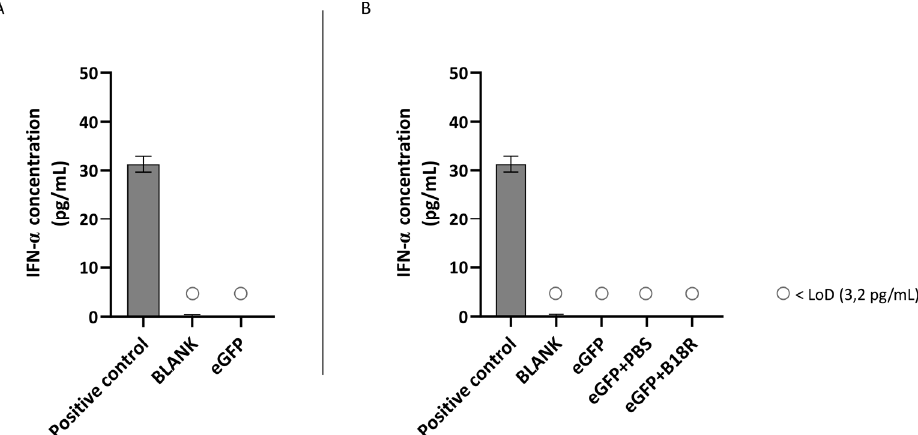
Figure 5. IFN-α production of ARPE-19 cells transfected with mRNA-MessengerMAX lipoplexes with or without B18R co-incubation as determined by ELISA (n = 3 × 3). ( A ) Absolute INF-α concentration in the supernatant 24 h following transfection of ARPE-19 cells with mRNA-MessengerMAX complexes without B18R addition. ( B ) IFN-α concentration, normalized to the group solely receiving mRNA-MessengerMAX complexes (eGFP), in the supernatant of ARPE-19 cells 24 h after transfection with mRNA-MessengerMAX complexes with or without B18R addition. The lowest concentration of IFN-α that could be detected with the used ELISA assay (LoD) was 3.2 pg/mL. Concentrations below the LoD are assigned with ○ . Both graphs contain a positive control with a concentration of 31 pg/mL derived from the standard curve obtained during the experiment.